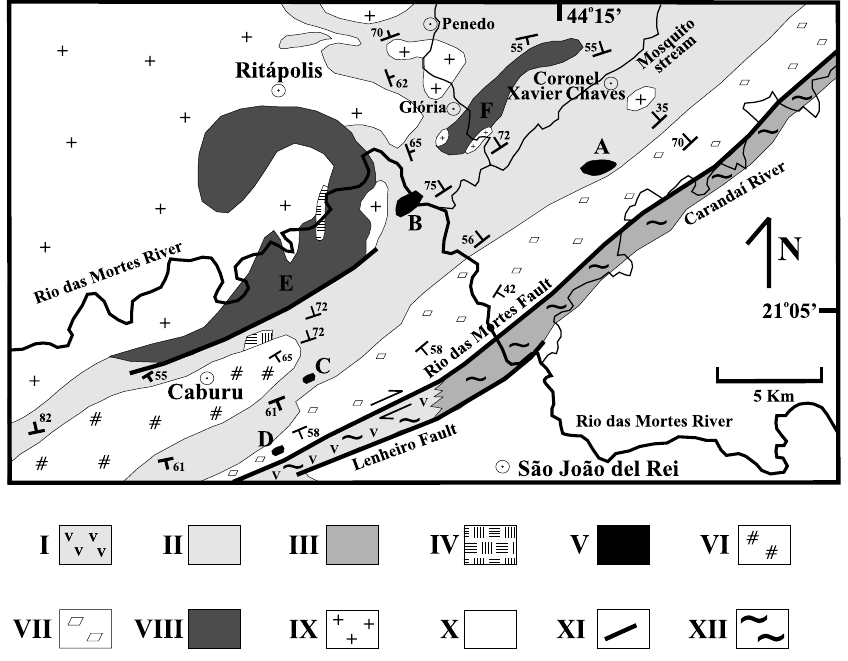
Fig. 2 – Geologic sketch of the region between Ritápolis, São João del Rei and Coronel Xavier Chaves, modified from Ávila et al. (2004). I – Metaultramafic, metapelite and metaquartzite rocks of the Nazareno greenstone belt. II – Amphibolites, metapelites, metaquartzites and gondites of the Rio das Mortes greenstone belt. III – Granitoid (mylonite). IV – Metaultramafic rock. V – Pyroxenite/gabbroic bodies (A, B, C, D). VI – Cassiterita tonalite/trondhjemite. VII – Fé granitic-gneiss. VIII – Dioritic/monzodioritic bodies (E: Brumado diorite; F: Glória quartz-monzodiorite). IX – Ritápolis granitoic. X – Proterozoic supracrustal sequences (São João del Rei, Carandaí and Andrelândia). XI – Faults. XII – Lenheiro shear zone, controlled by the Rio das Mortes and Lenheiro faults. The main orientation of the plutons, as well as the network of tectonic structures, reflect the NW trend of the Mineiro belt. See text for